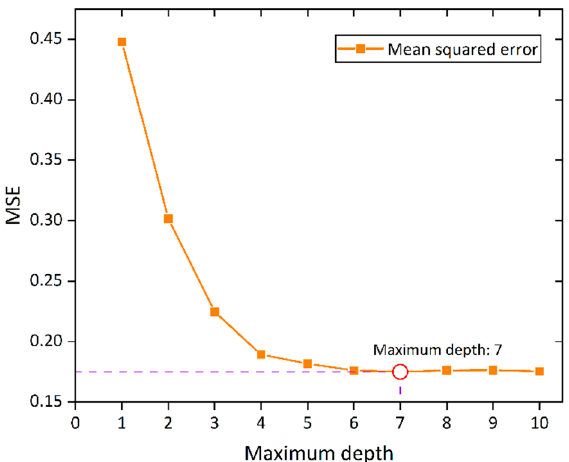
Figure 6. MSE with respect to the maximum depth of trees in a forest.